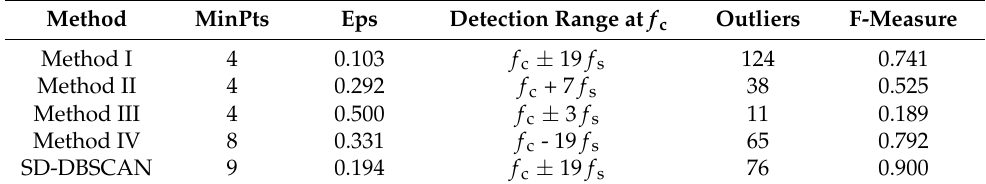
Table 7. The results of different detection